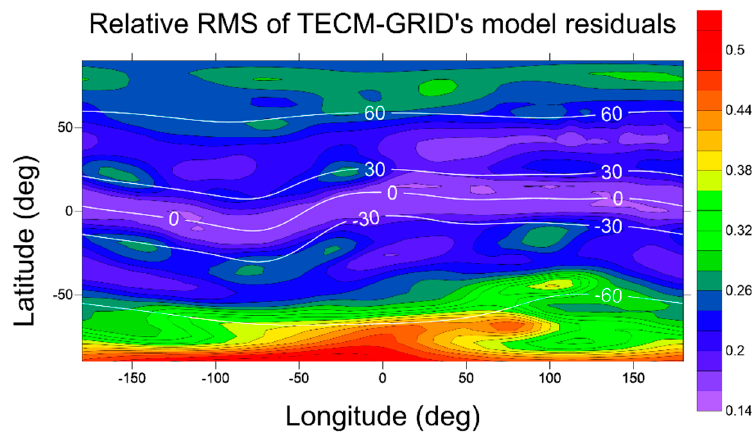
Figure 4. Relative RMS values of model residuals for TECM-GRID.